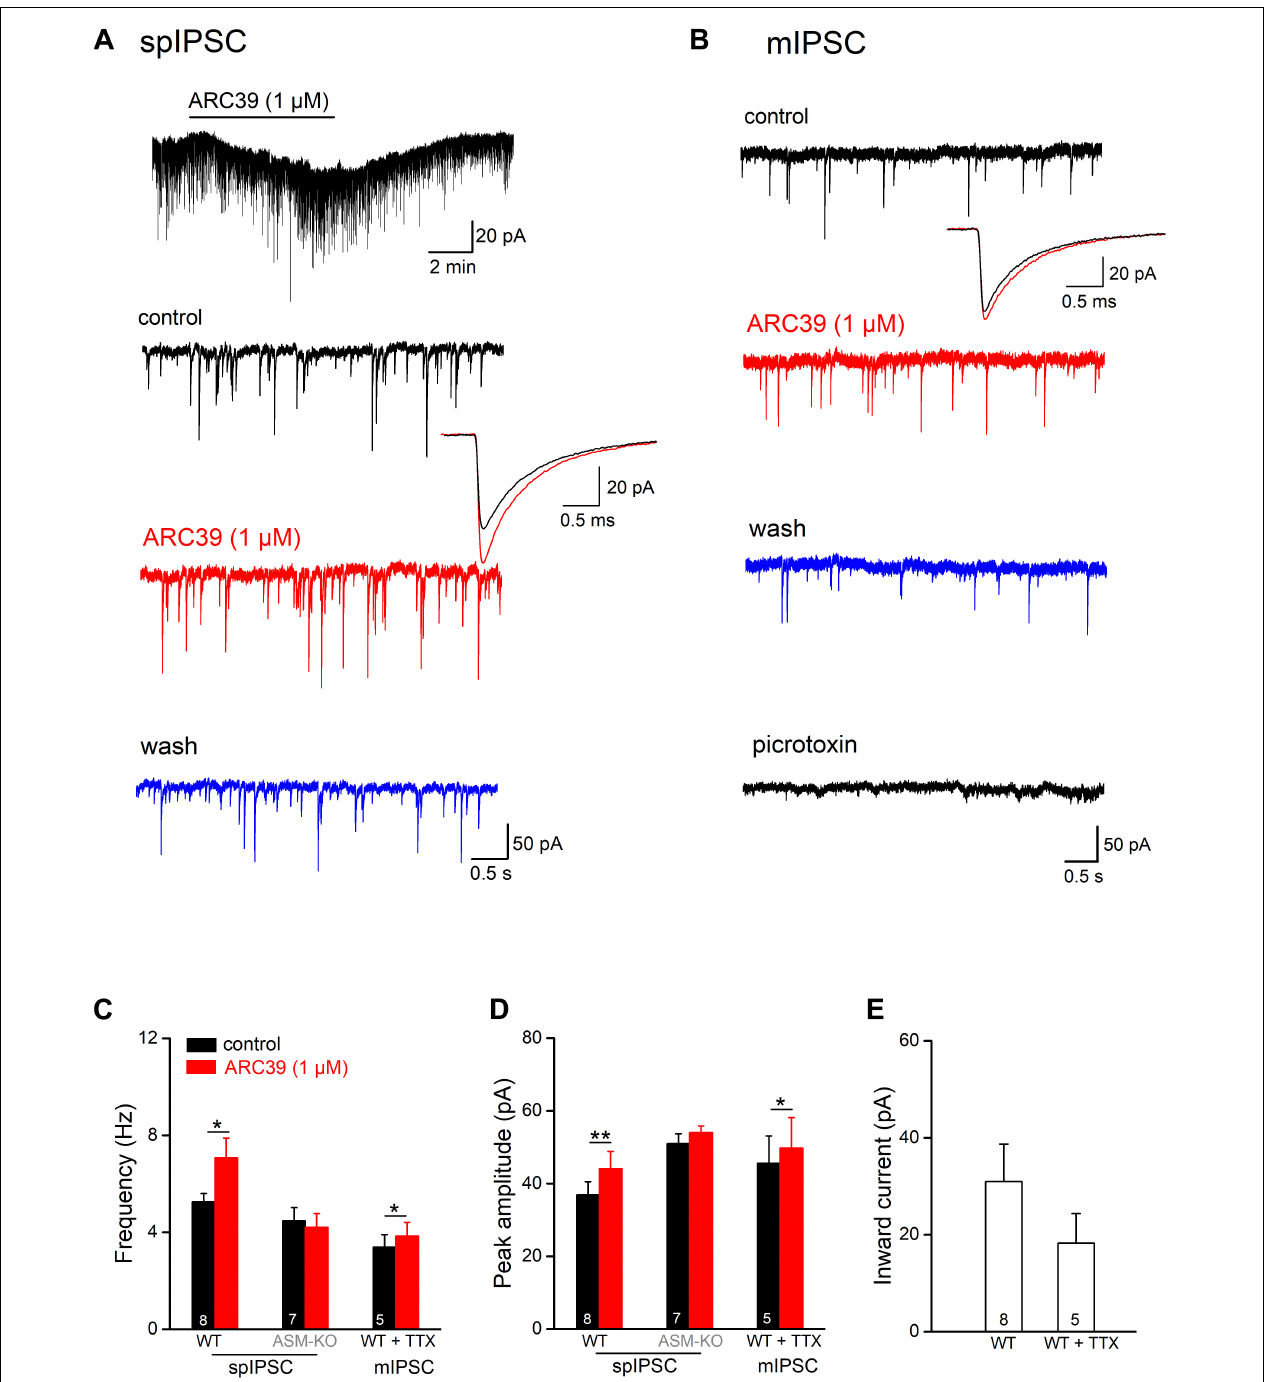
FIGURE 3 | ARC39 augments frequency and amplitude of IPSCs in CA1 pyramidal cells. Spontaneously occurring inhibitory synaptic events were recorded with CsCl-filled pipettes in the presence of KA (2 mM) to block ionotropic glutamate receptors at –70 mV. (A,B) Raw current traces illustrate the facilitating effects of ARC39 on spontaneous IPSCs [spIPSCs; (A) ] and miniature IPSCs [mIPSCs, in 0.5 µ M TTX; (B) ] in two pyramidal cells from wt slices. The trace above in panel (A) is a scope recording showing the time course of holding current. spIPSCs and mIPSCs were collected before ARC39 application (control), 5–6 min in ARC39 (1 µ M, red trace), and after 8–10 min of washout (blue trace). The averaged events before (black trace) and during ARC39 application (red trace) were enlarged and superimposed to depict the kinetics of IPSCs. At the end of the experiment in panel (B) , PTX (100 µ M) was applied to verify the GABAergic nature of spontaneous events. (C,D) Histograms summarize effects of acute ARC39 (1 µ M) on frequency (C) and averaged amplitude (D) of spIPSCs and mIPSCs. (E) Quantification of ARC39-induced change in holding current without and with TTX (0.5 µ M). Note broad suppression of K + channels by high Cs + -based pipette solution. * p < 0.05, and ** p <